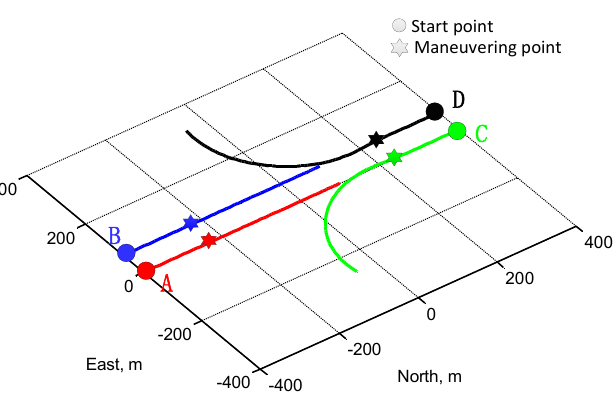
Figure 18. 3D flight path.